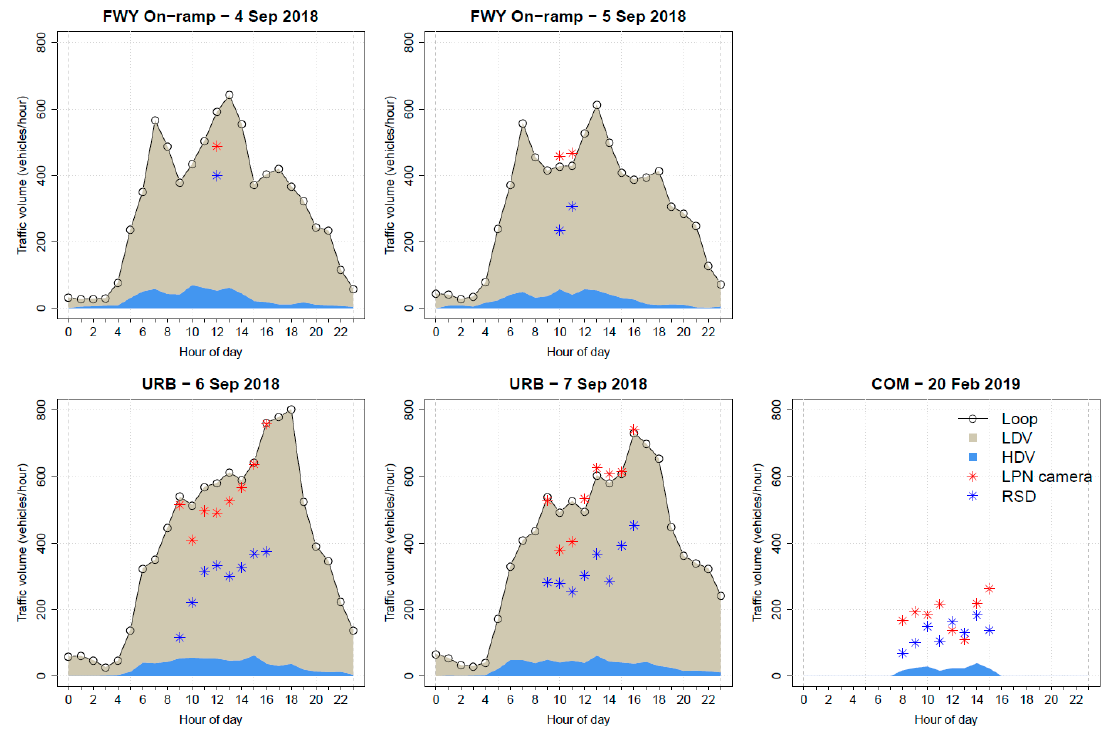
Figure 2. Traffic count results at three sites using three types of equipment. Figure 2. Tra ffi c count results at three sites using three types of